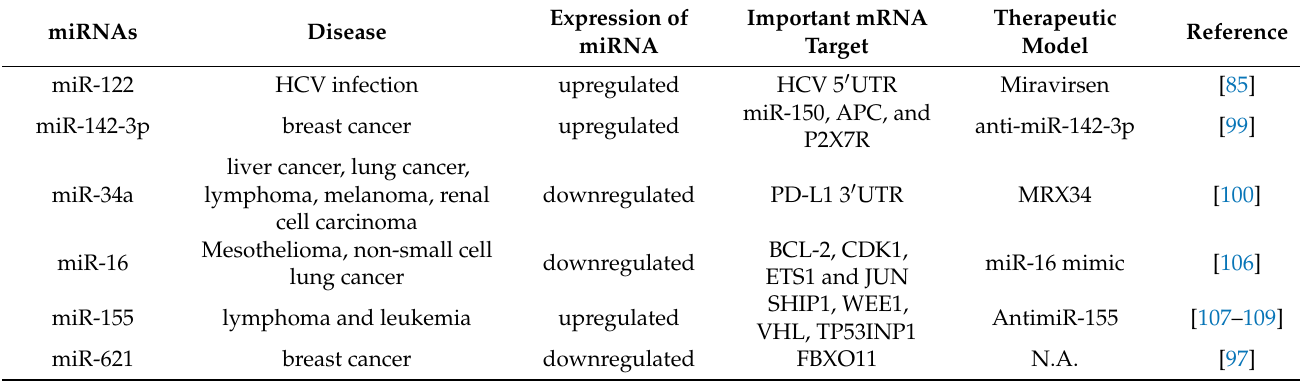
Table 1. Selected miRNAs in cancers and their therapeutic